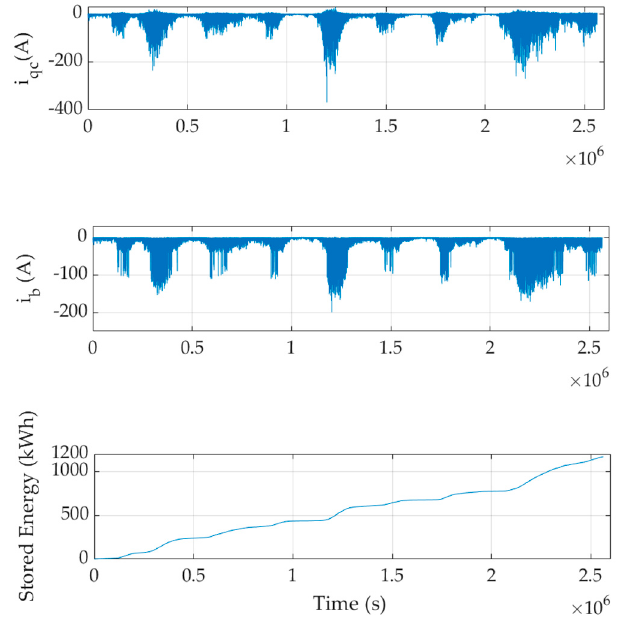
Figure 9. Energy storage module behaviors in March